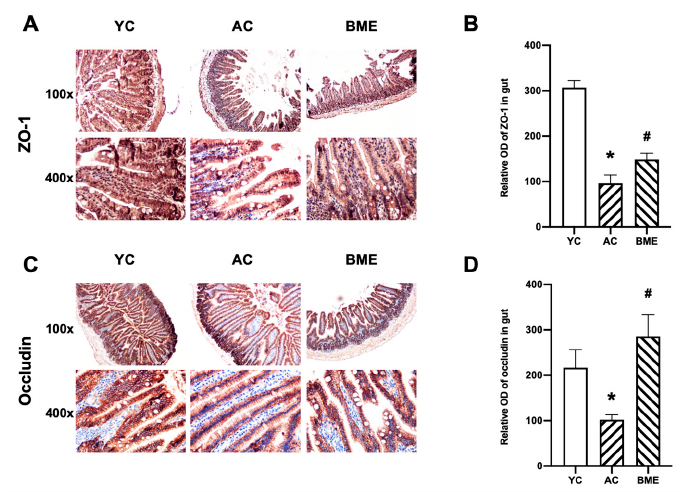
Figure 5. Immunohistochemical staining and optical density (OD) values of intestinal tight junction proteins in mouse intestines. Representative micrographs of ( A ) ZO-1 and ( C ) occludin immunostaining visualized with DAB and counterstained with hematoxylin. Integrated OD values of ( B ) ZO-1 and ( D ) occludin were used to analyze the results of the immunohistochemistry. All results are expressed as means ± SEMs ( n = 3). * p < 0.05 versus YC group, # p < 0.05 versus AC group. AC: aged control, BME: blueberry–mulberry extract, YC: young control, ZO-1: zonula occludens-1.